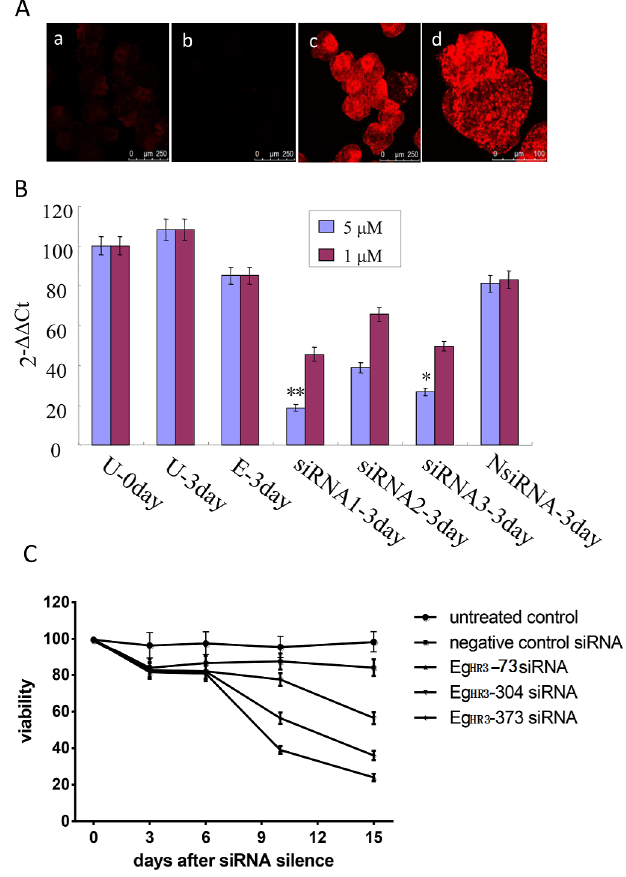
Figure 7. Silencing of EgHR3 by siRNAs. Ef fi ciency of electroporation for transformation of control labeled siRNA into PSC. a and b, untransformed PSC; c and d, transformed PSCs (A). Silencing ef fi cacy of siRNA for EgHR3 in PSCs at two concentrations (1 and 5 m M) of siRNA. U-0 day and U-3 day, untreated PSCs or untreated PSCs cultured in vitro for 3 days; E-3 day, PSCs treated by electroporation only and then cultured for 3 days; siRNA1-3, siRNA EgHR3 -73, siRNA EgHR3 -304 and siRNA EgHR3 -373 transfected PSCs which were cultured in vitro for 3 days; NsiRNA-3 day, non-labeled negative control siRNA transfected PSCs which were cultured in vitro for 3days (B). Silencing ef fi cacy of small RNA fragments on the viability of E. granulosus PSC